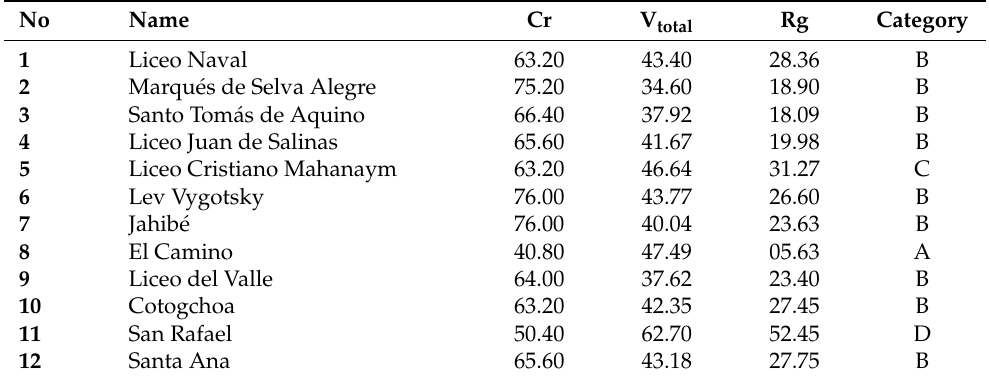
Table 13. Vulnerability comparisons of the assessed